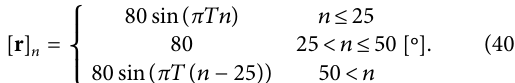
Frontiers in Robotics and AI |